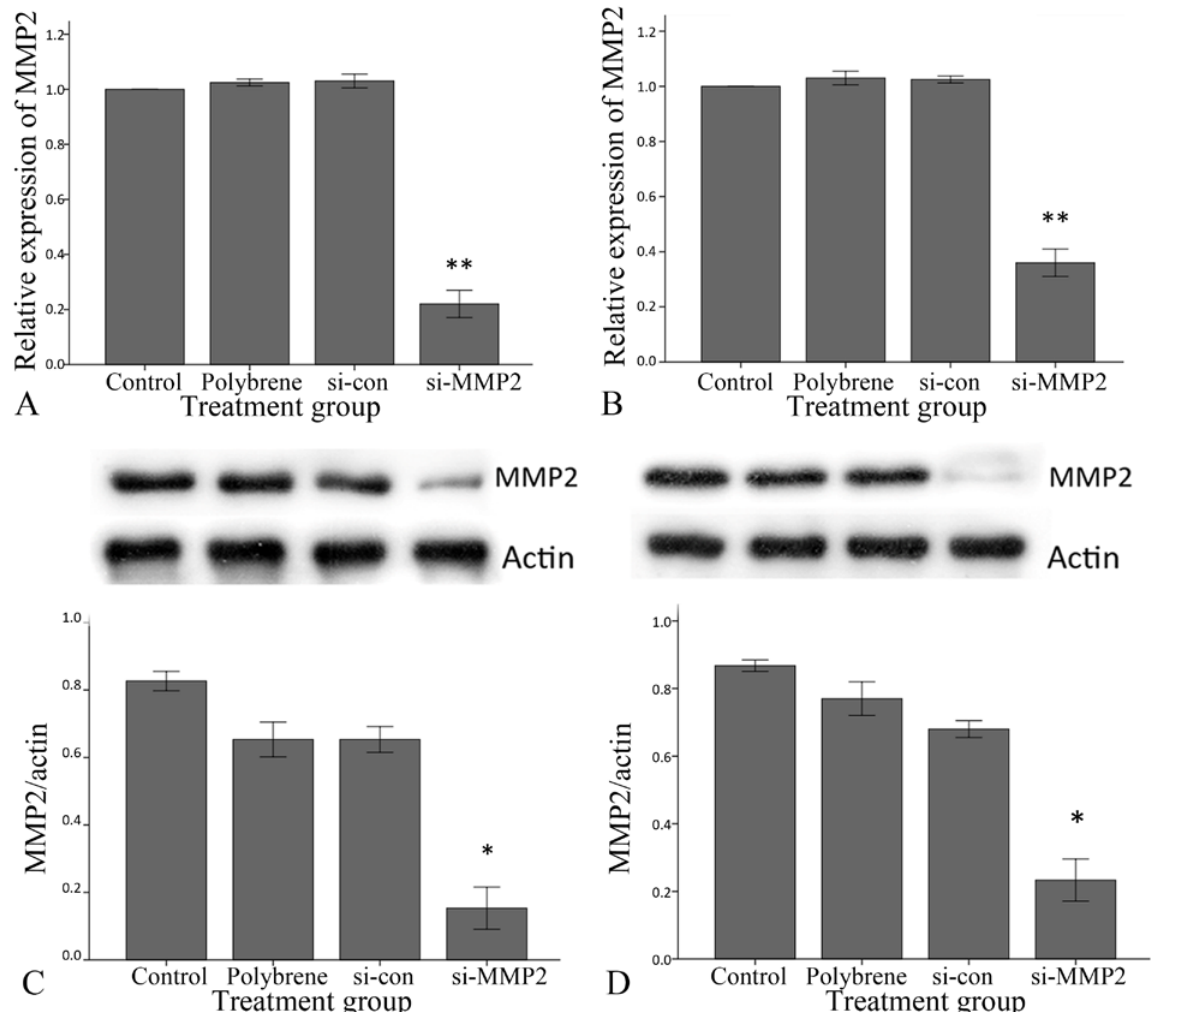
Figure 1. si-MMP2 knockdown efficiency. A, The knockdown efficiency according to the relative mRNA expression levels of MMP2 in HepG2 cells in the normal control, polybrene, si-control, and si-MMP2 groups based on real-time quantitative polymerase chain reaction (RT-qPCR). B, The knockdown efficiency according to the relative mRNA expression levels of MMP2 in Huh7 cells in the normal control, polybrene, si-control, and si-MMP2 groups based on RT-qPCR. C, The relative protein levels of MMP2 in HepG2 cells in the normal control, polybrene, si-control, and si-MMP2 groups based on western blot assays. D, The relative protein levels of MMP2 in Huh7 cells in the normal control, polybrene, si-control, and si-MMP2 groups based on western blot assays. ** P<0.01 vs. the normal control group, according to one-factor analysis of variance (ANOVA) followed by a post hoc least significant difference (LSD)